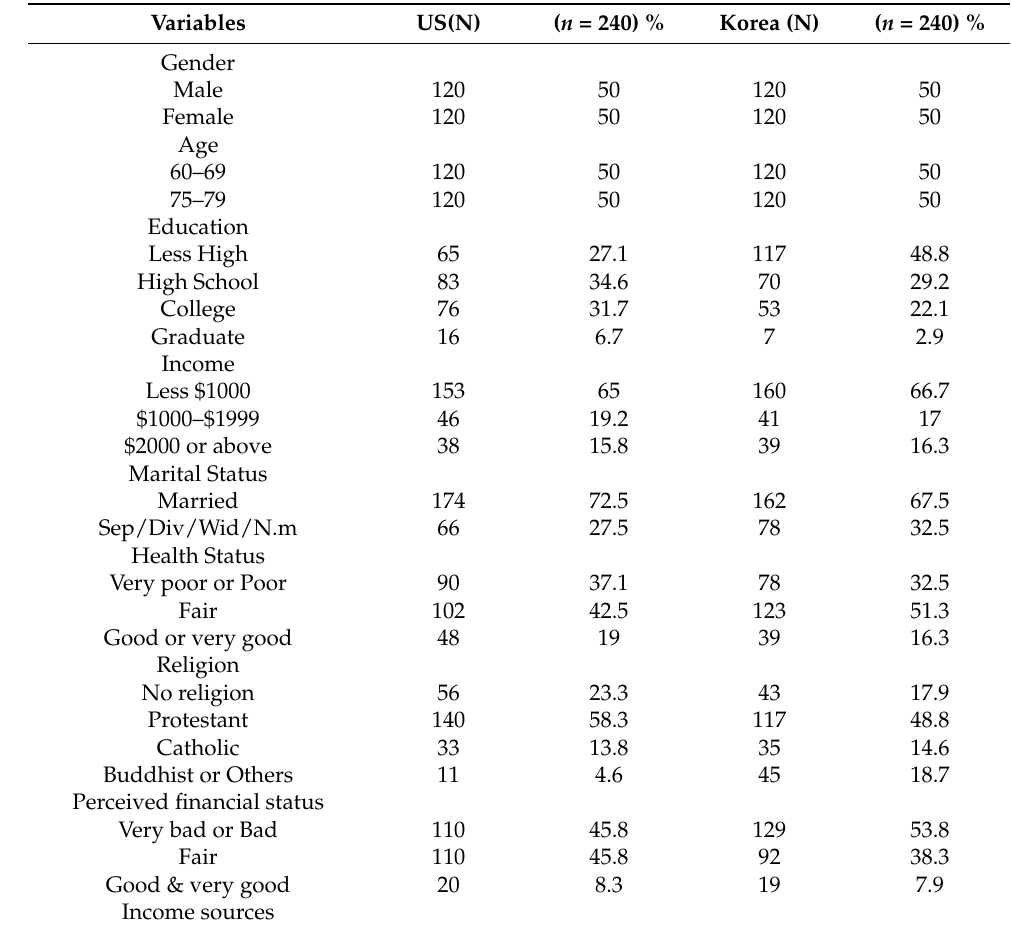
Table 1. Socio-demographic characteristics of the sample (US: n = 240 & Korea: n = 240). Variables